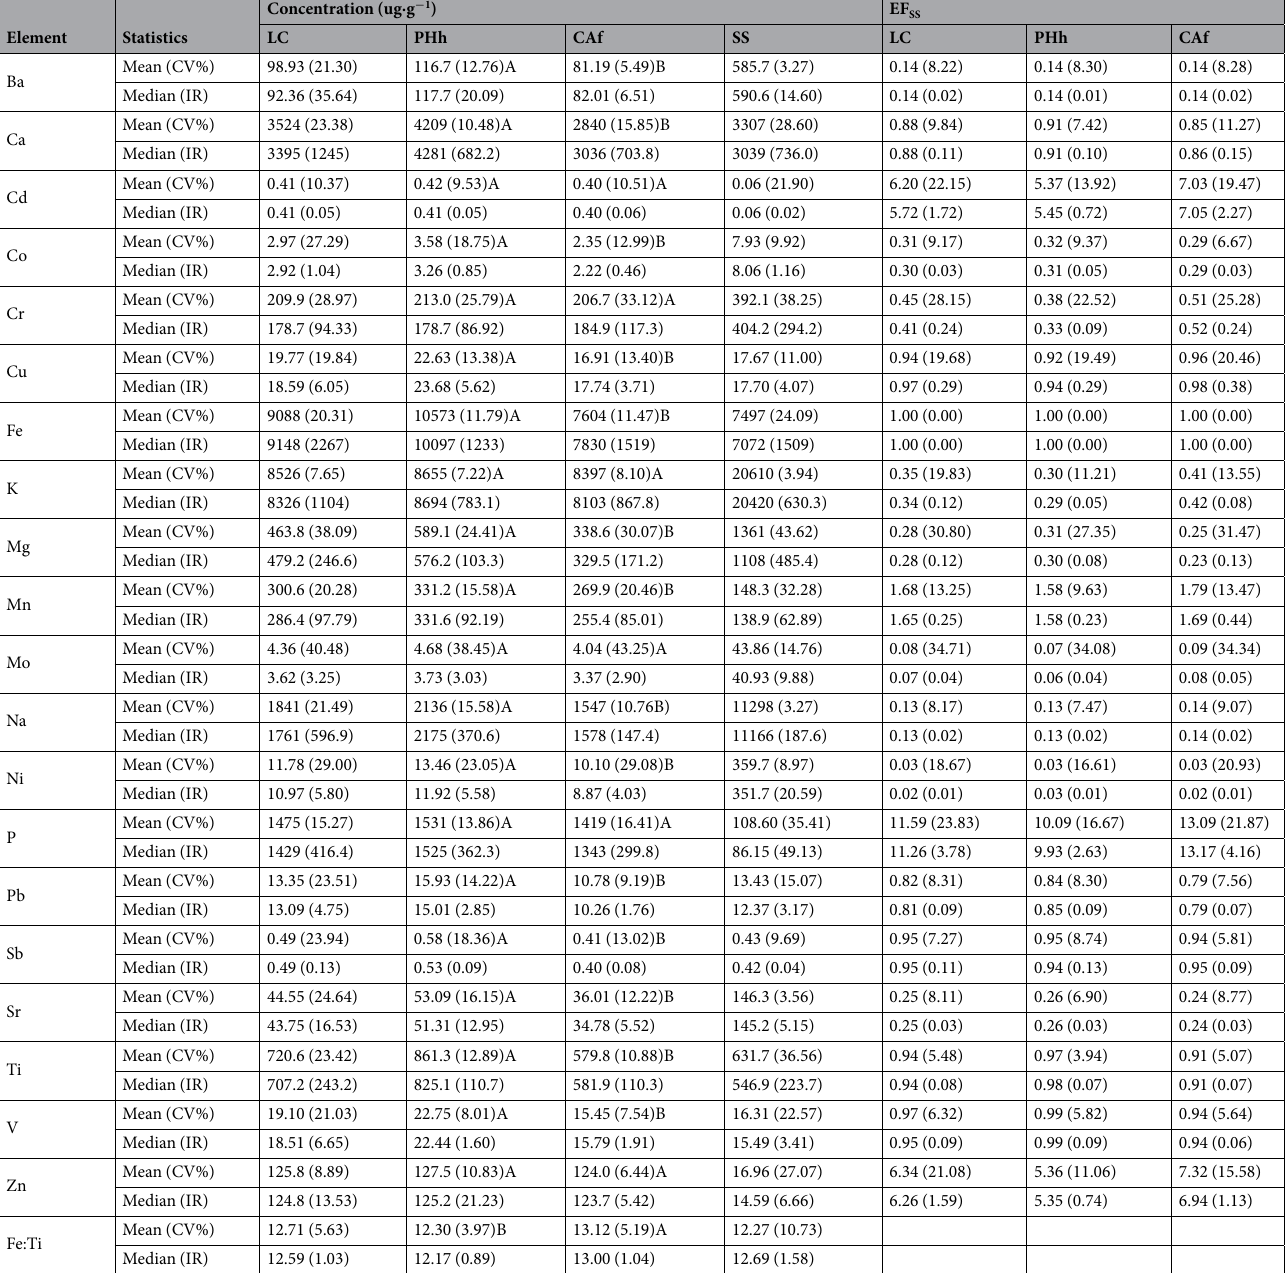
Table 1. Elemental concentration, EF SS and Fe:Ti ratio in lichens and surface soil from a Populus forest, near a provincial road in Duolun County, Inner Mongolia, China. Different capitalised letters in each row indicate a significant difference in element concentration between the two lichens (p ≤ 0.05) based on Paired-Samples T test performed on the raw concentrations. CV refers to the coefficient of variance (defined as the ratio of standard deviation values to mean concentration values). IR refers to the interquartile range (defined as the difference between percentile 75% and percentile 25%). EF SS refers to the enrichment factor normalised to the local surface soil with Fe as a reference element according to Equation 1. LC refers to lichen combined (n = 24). PHh refers to Phaeophyscia hirtuosa (n = 12). CAf refers to Candelaria fibrosa (n = 12). SS refers to surface soil (n =